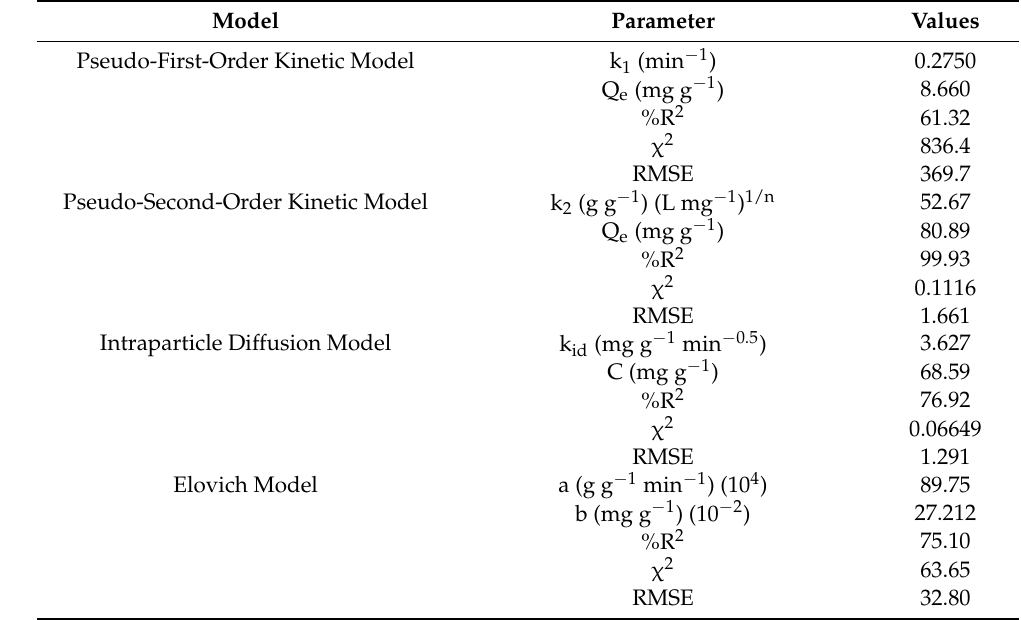
Table 5. Summary of the kinetics of CV dye adsorption by the IZNC by various kinetic models. Model